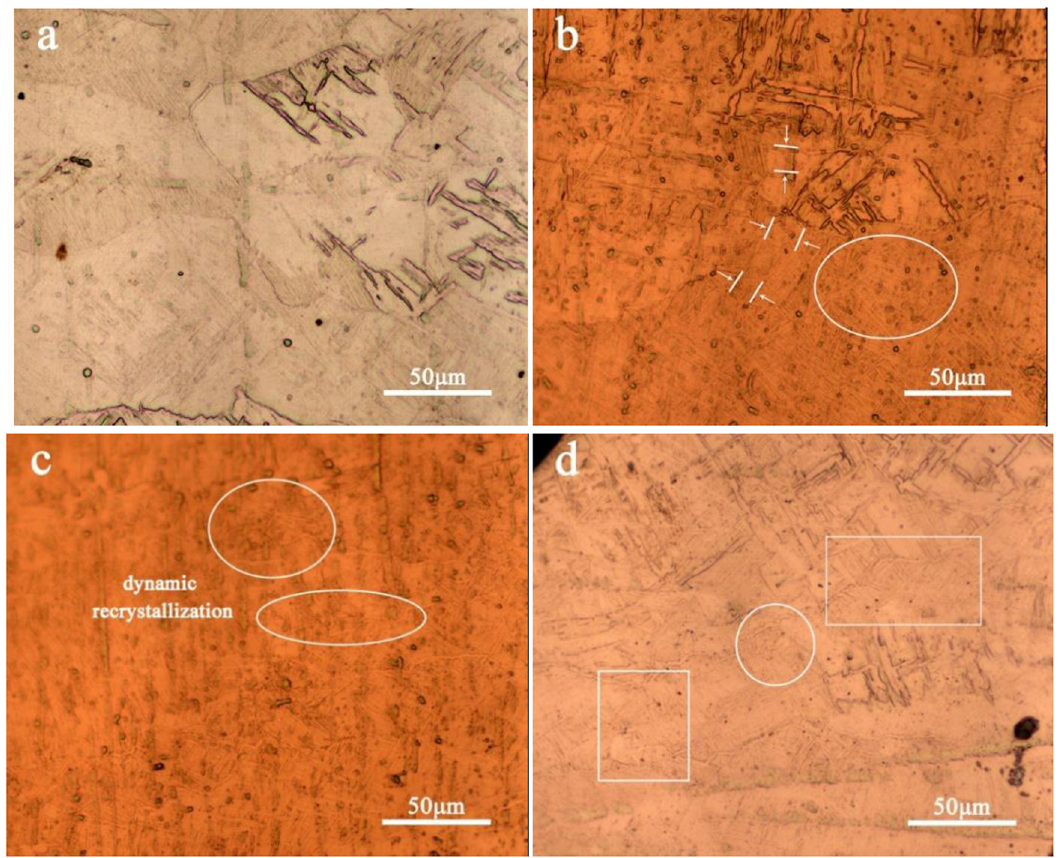
Figure 10: OM images of the samples at the deformation of three - pass: ( a ) 0.01 s − 1 , ( b ) 0.1 s − 1 , ( c ) 1 s − 1 and ( d ) 5 s − 1 .